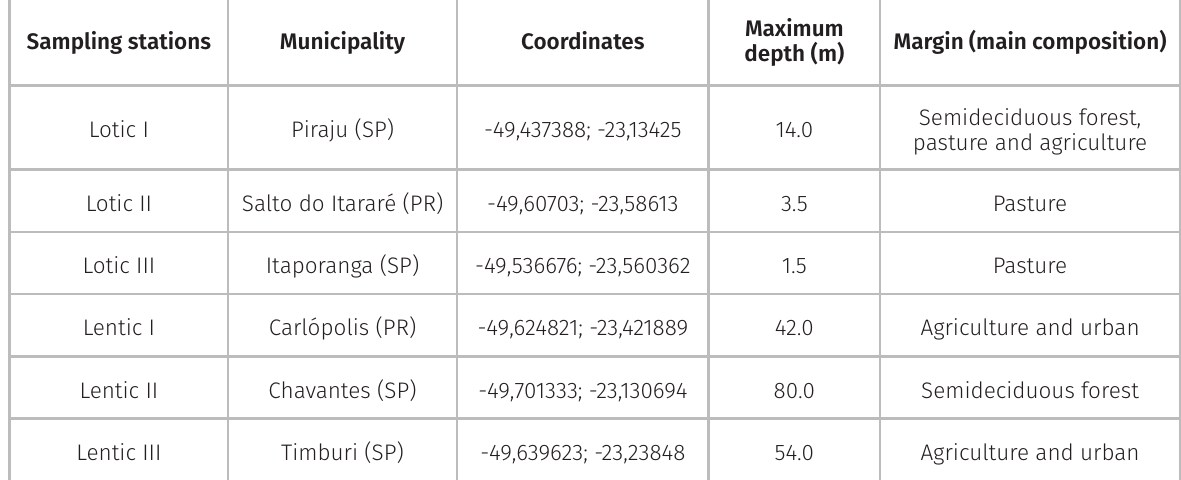
Table I. Characterization of the lotic and lentic sampling sites studied, influenced by the Chavantes Reservoir, Paranapanema